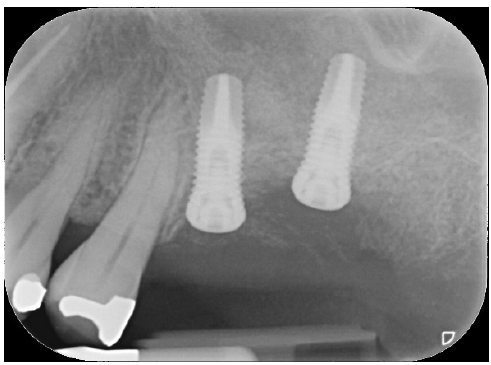
Figure 4. Radiographic control at 5 years.